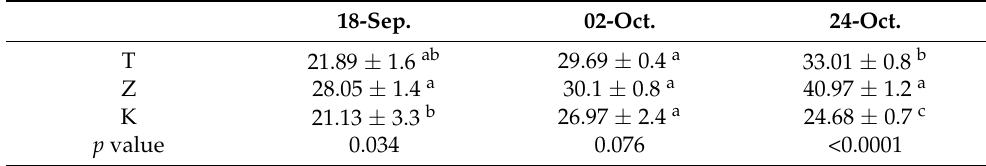
Table 1. Percentage of oil content on olive dry weight. Data are expressed as mean of three replicates ± standard deviation. (T = untreated control, Z = zeolitite, K = kaolin).